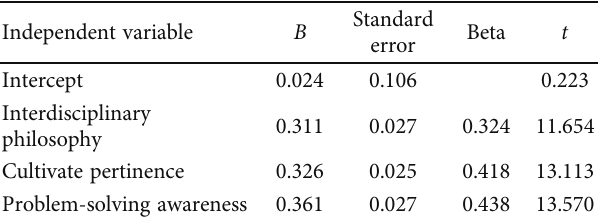
Table 4: Summary table of multiple linear regression analysis of training